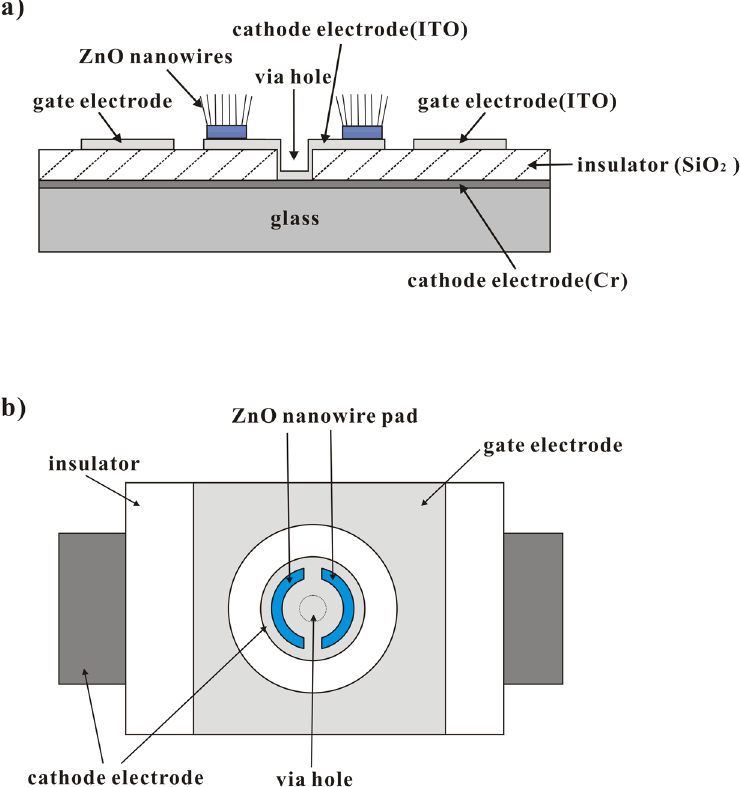
Figure 1. Schematic diagrams of the coplanar-gate ZnO nanowire FEA structure: ( a ) cross-sectional view; ( b ) top